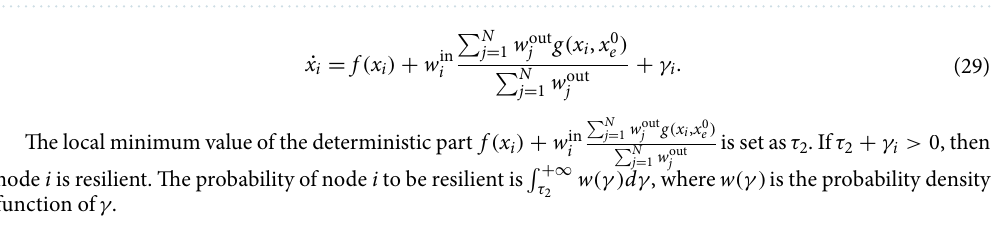
Figure 5. Critical resilience value identifies vulnerable nodes with certain parameters. ( a ) Resilience bounds show the upper-bound and lower-bound of equilibrium when links removed. In this figure, it explicitly predicts when the loss of resilience will happen. ( b ) Critical resilience shows the relationship between average weight value of network and critical weight value. When w in i > w crit , the node is resilient; otherwise it is